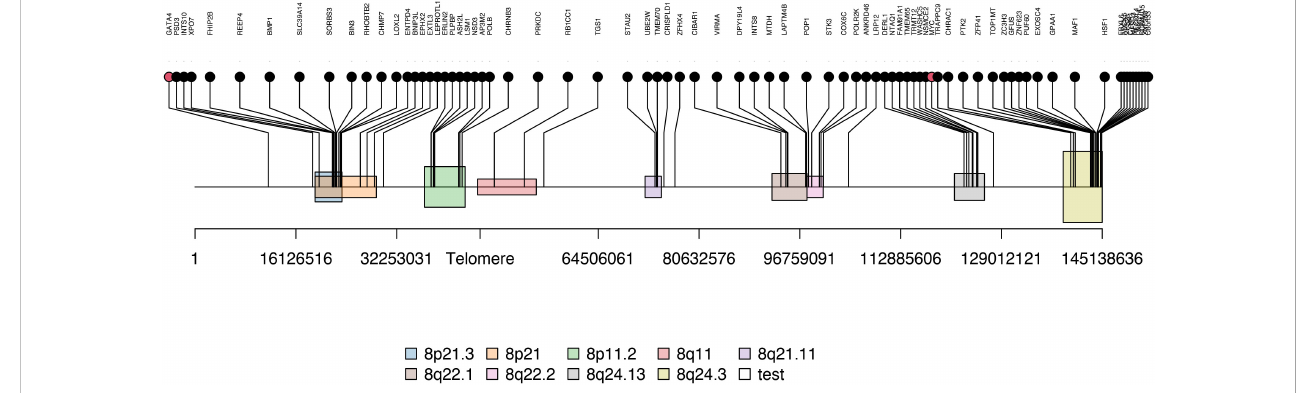
FIGURE 3 The enriched cytobands of Module 2 genes. Black dots are module 2 genes enriched on chromosome 8 and red dots are transcription factor (i.e. MYC and GATA4) located near or on the identi fi ed Module 2-enriched